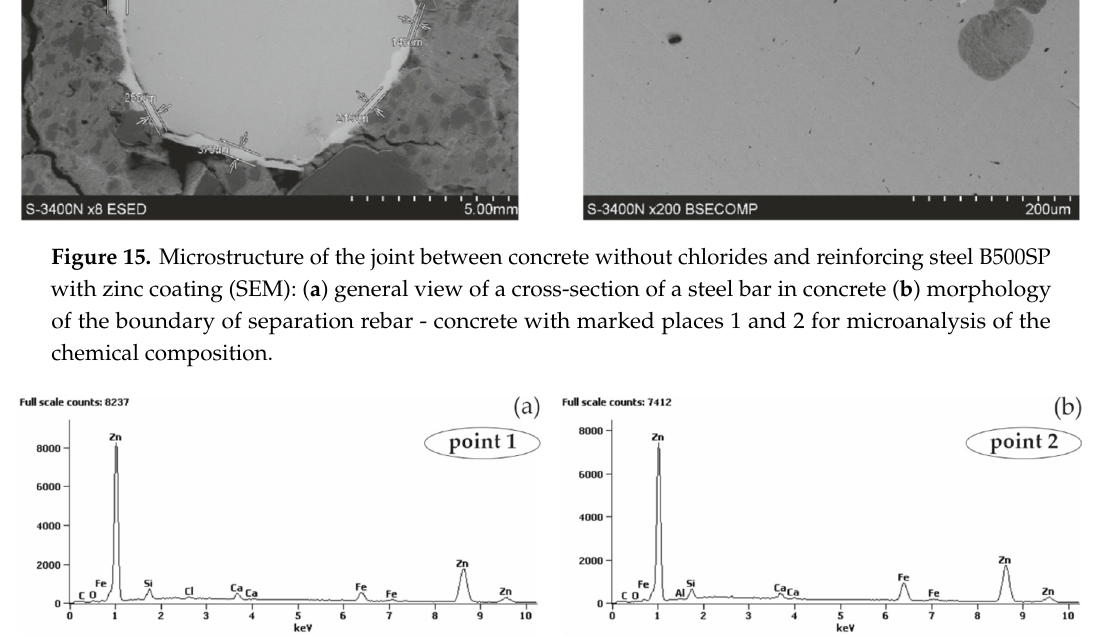
Figure 16. Spectra obtained from energy-dispersive X-ray spectroscopy (EDS) method for areas marked in Figure 15b: ( a ) from point 1 ( b ) from point 2.